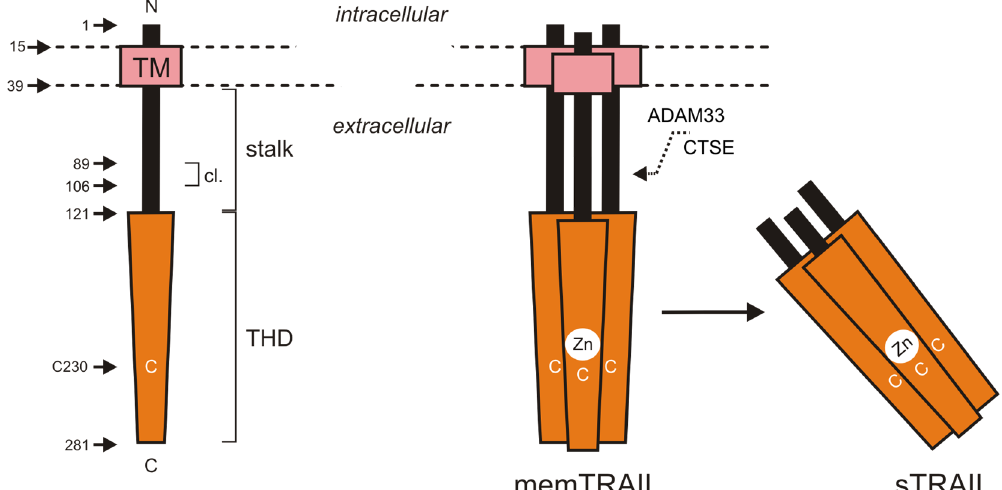
Figure 1. Domain architecture of TRAIL. “cl” indicates a region (aa 89–106) within the stalk region containing one or more sites for proteolytic processing [3]; THD, TNF homology domain; TM, transmembrane domain. For more details see main text.